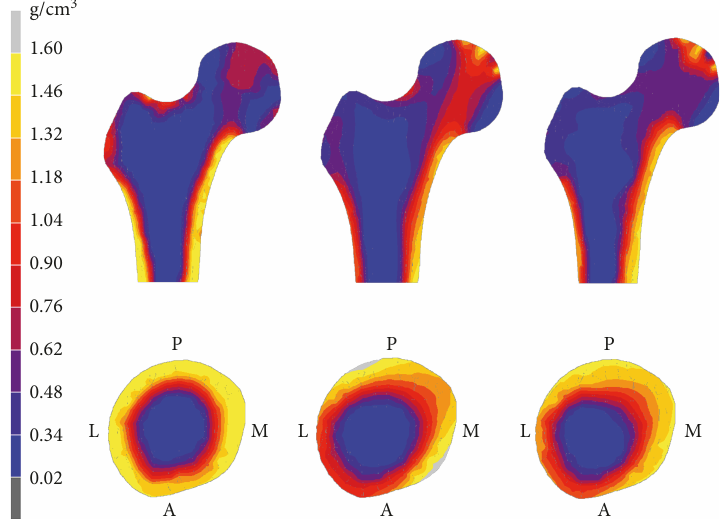
Figure 4: The bone density distribution in coronal and transverse section of the proximal femur. The densities obtained from the CT data, simulation by the isotropic algorithm, and simulation by the orthotropic algorithm were shown from left to right. The upper row is the density distribution in coronal section. The lower row is the density distribution in transverse section. L: lateral; M: medial; A: anterior; P: posterior. The value of Ψ used in both algorithms was 0.012. 0